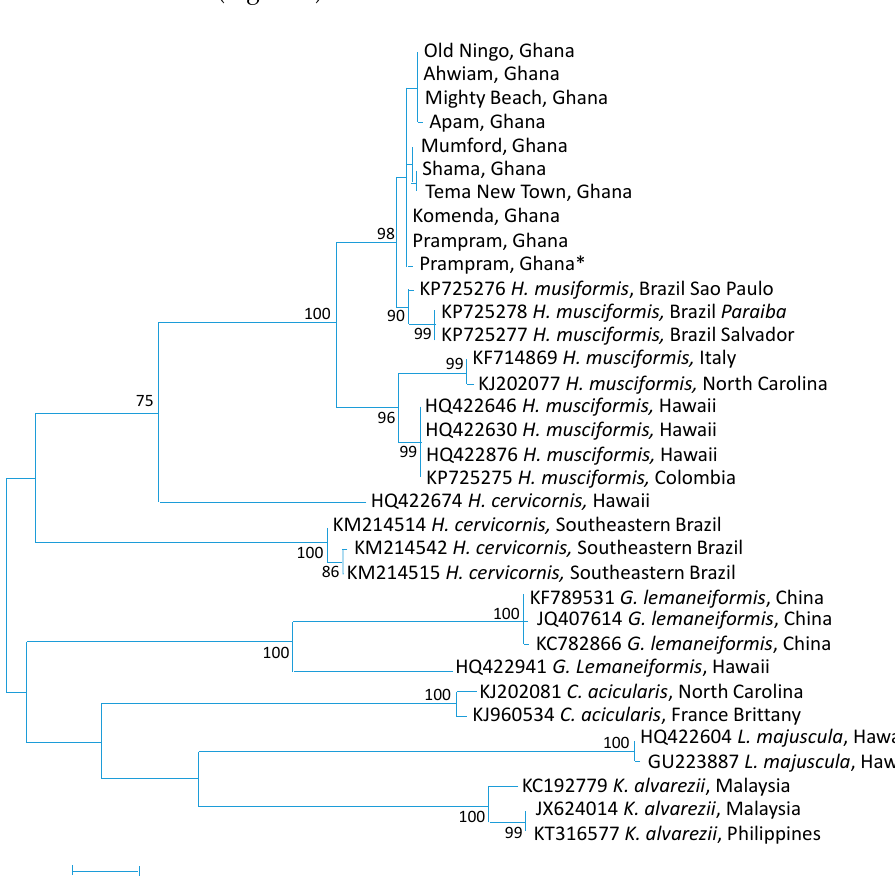
0.02 Figure 3. Phylogenetic tree based on multiple alignment of COI barcodes sequences of the specimens collected from different sites along the Ghanaian coast (named after their location) and selected COI barcodes sequences of other red seaweed from the NCBI GenBank. The history of phylogenetic relationship comparison was performed using the maximum likelihood method, based on the Kimura two-parameter model [30]. * Hypnea sp. doubted to be as Hypnea cervicornis by local the taxonomist.